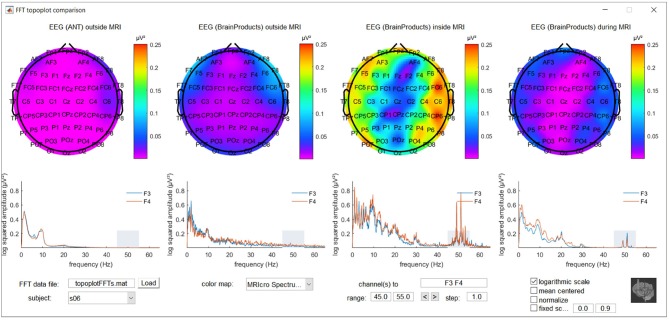
Screenshot of the MATLAB based graphical user interface incorporating the topoplot functionality from EEGLAB, allowing the topographical exploration of fast Fourier transform (FFT) squared amplitudes for a selected frequency range for different recording conditions, with interactive options to selectively view specific frequency ranges and electrode subsets and offering different forms of scaling and color coding. FFT information around the powerline noise frequency of one of the subjects included in the study is shown as an example.